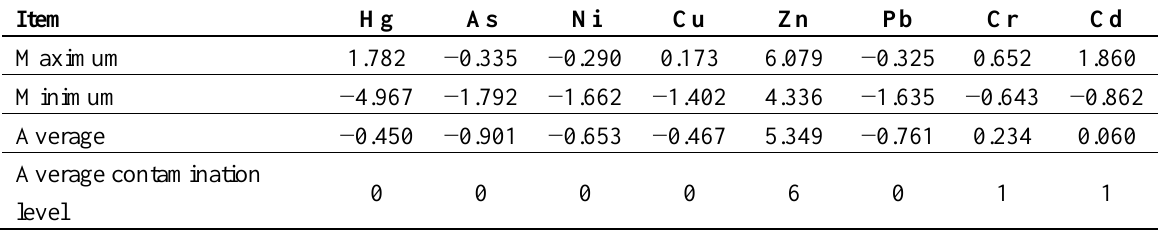
Table 3. Contamination index and level of different heavy